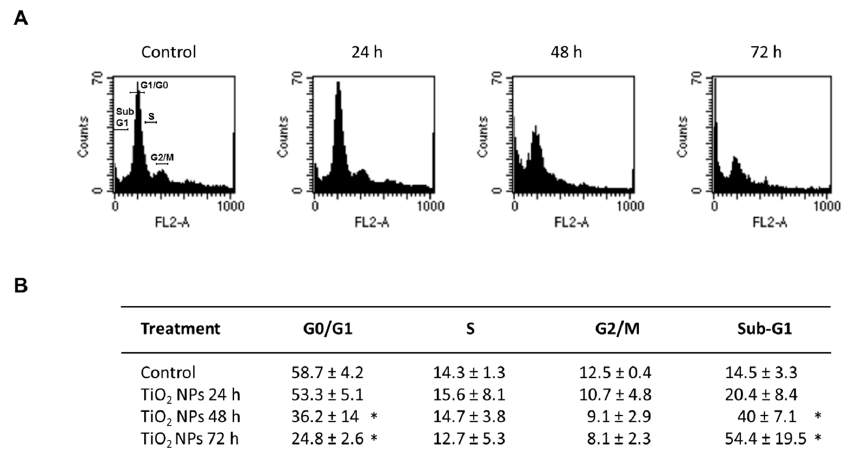
Figure 5. Effect of TiO 2 NPs on cell cycle. H9c2 cells were treated with 20 μ g/cm 2 TiO 2 NPs for 24, 48, and 72 h and cell cycle was analyzed by quantitation of DNA content through flow cytometry. Histograms ( A ) and table ( B ) show the percentage of cell populations in each phase. In ( B ), data were analyzed by the CellQuest Pro software (Becton Dickinson) and expressed as mean ± standard deviation (SD) of three independent experiments ( n = 3). * Significant difference between control (untreated) and treated cells ( p < 0.05).